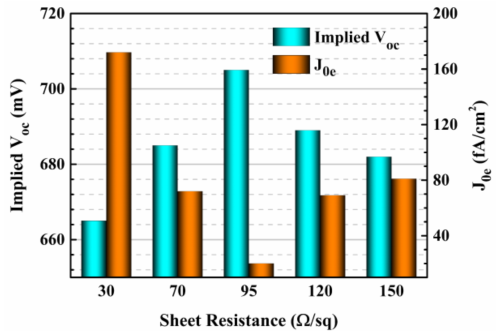
Figure 9. J 0e and implied V oc as a function of di ff erent front surface doping layer sheet resistances (i.e., di ff erent FSF doping concentrations) of the fabricated IBC solar